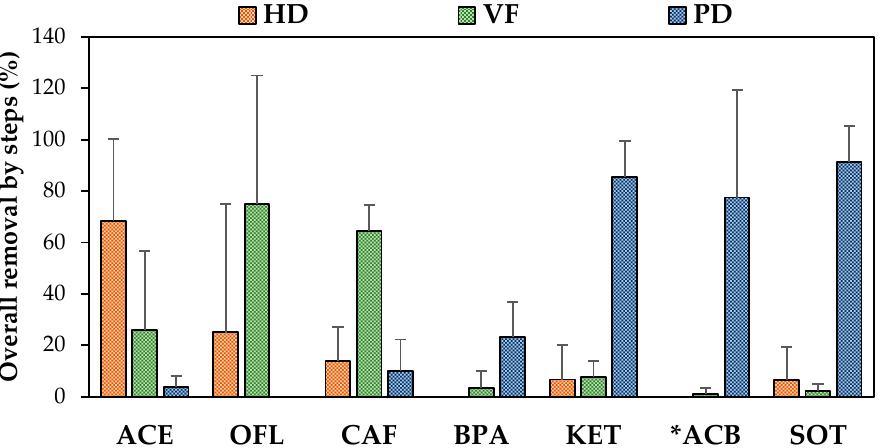
Figure 6. Overall removal of several EPs in the different steps of the combined HD–VF–PD system (* for ACB, mean of periods II and III only, because the intermediate concentration for period IV was not available) (Error bars: only value + standard deviation is shown). See Table 4 for pollutant abbreviations.